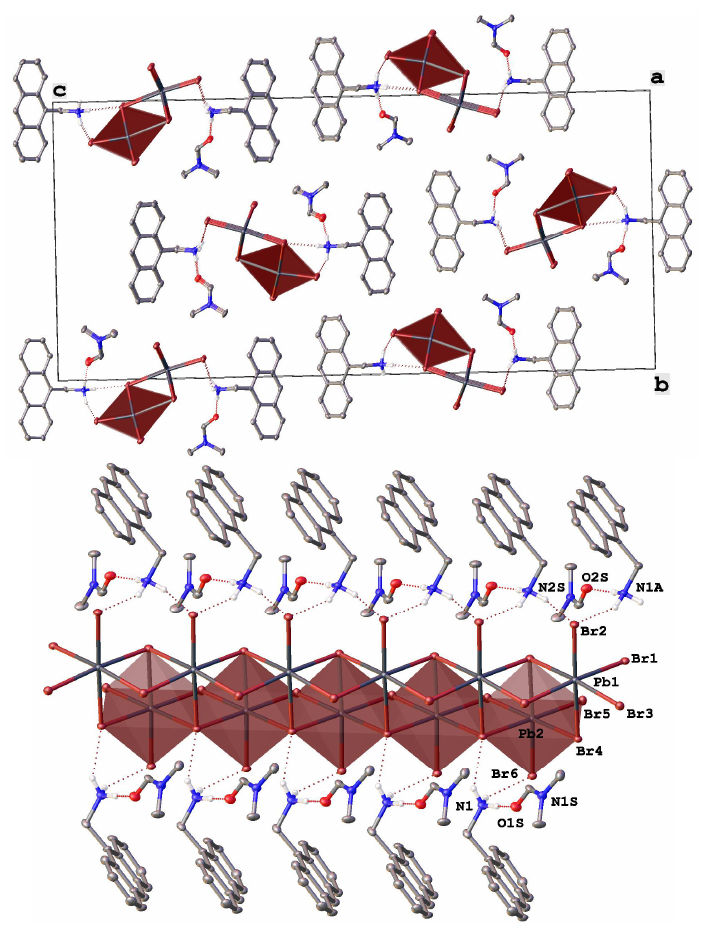
Figure 1. Fragments of the crystal packing in [AntrNH 3 ][PbBr 3 ](DMF) ( a ) illustrating the formation of 1D ladder-like chains from lead bromide octahedra (highlighted by pink color) along the crystallographic axis a and ( b ) a view perpen- dicular to this axis. Hydrogen atoms except those of NH 3 groups are omitted for clarity, non-hydrogen atoms are shown as thermal ellipsoids ( p = 30%) and only labels of the heteroatoms in an asymmetric part of the unit cell are given. Table 2. Main geometric parameters and continuous symmetry measures 1 as obtained from X-ray diffraction for [An- trNH 3 ][PbBr 3 ](DMF), [PyrNH 3 ][Pb 2 Br 6 ][DMFH](DMF) 2 and [StyrNH 3 ] 2 [PbBr 4 ]. Parameter